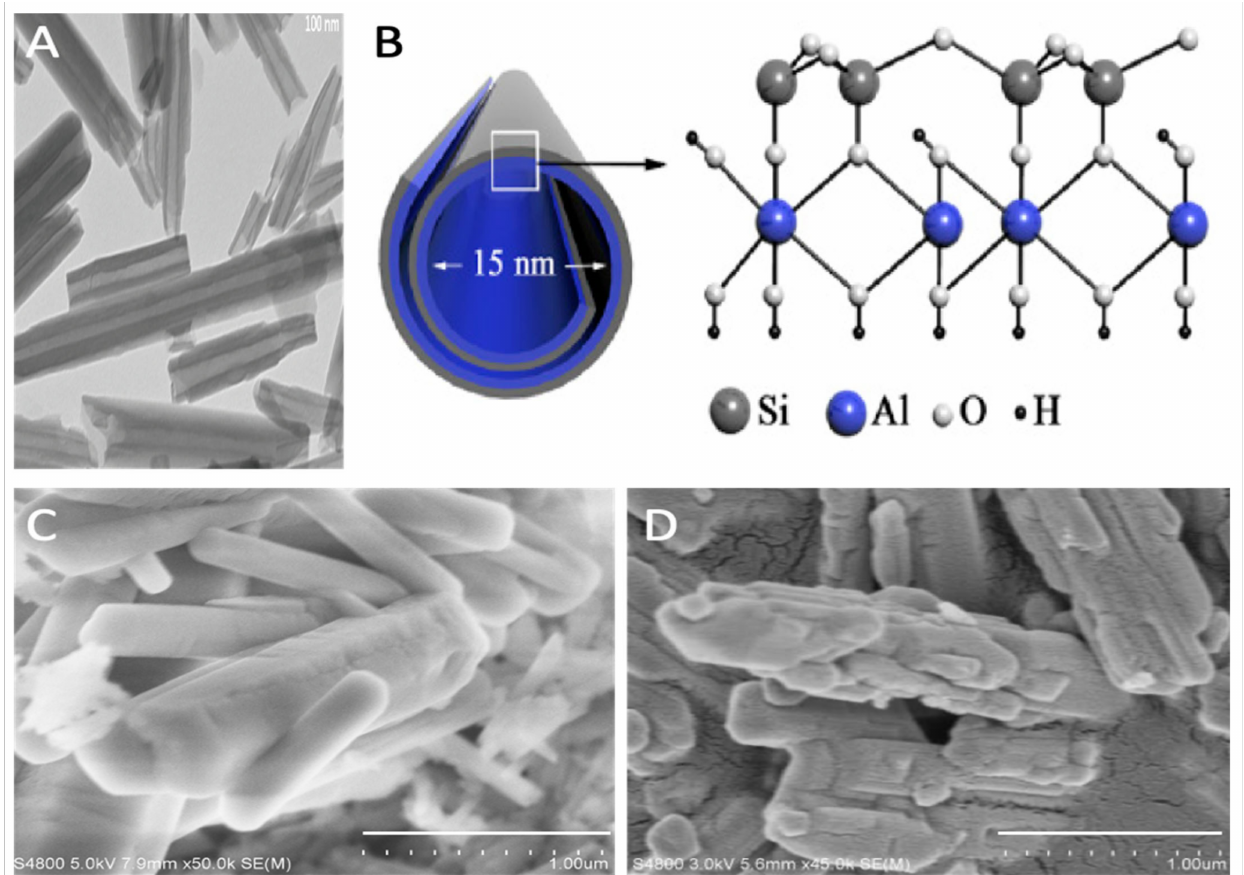
Figure 1. ( A ) TEM of halloysite showing the prominent lumen. ( B ) Chemical structure of halloysite. ( C ) Magnesium-coated halloysite nanotubes. ( D ) Strontium-coated halloysite